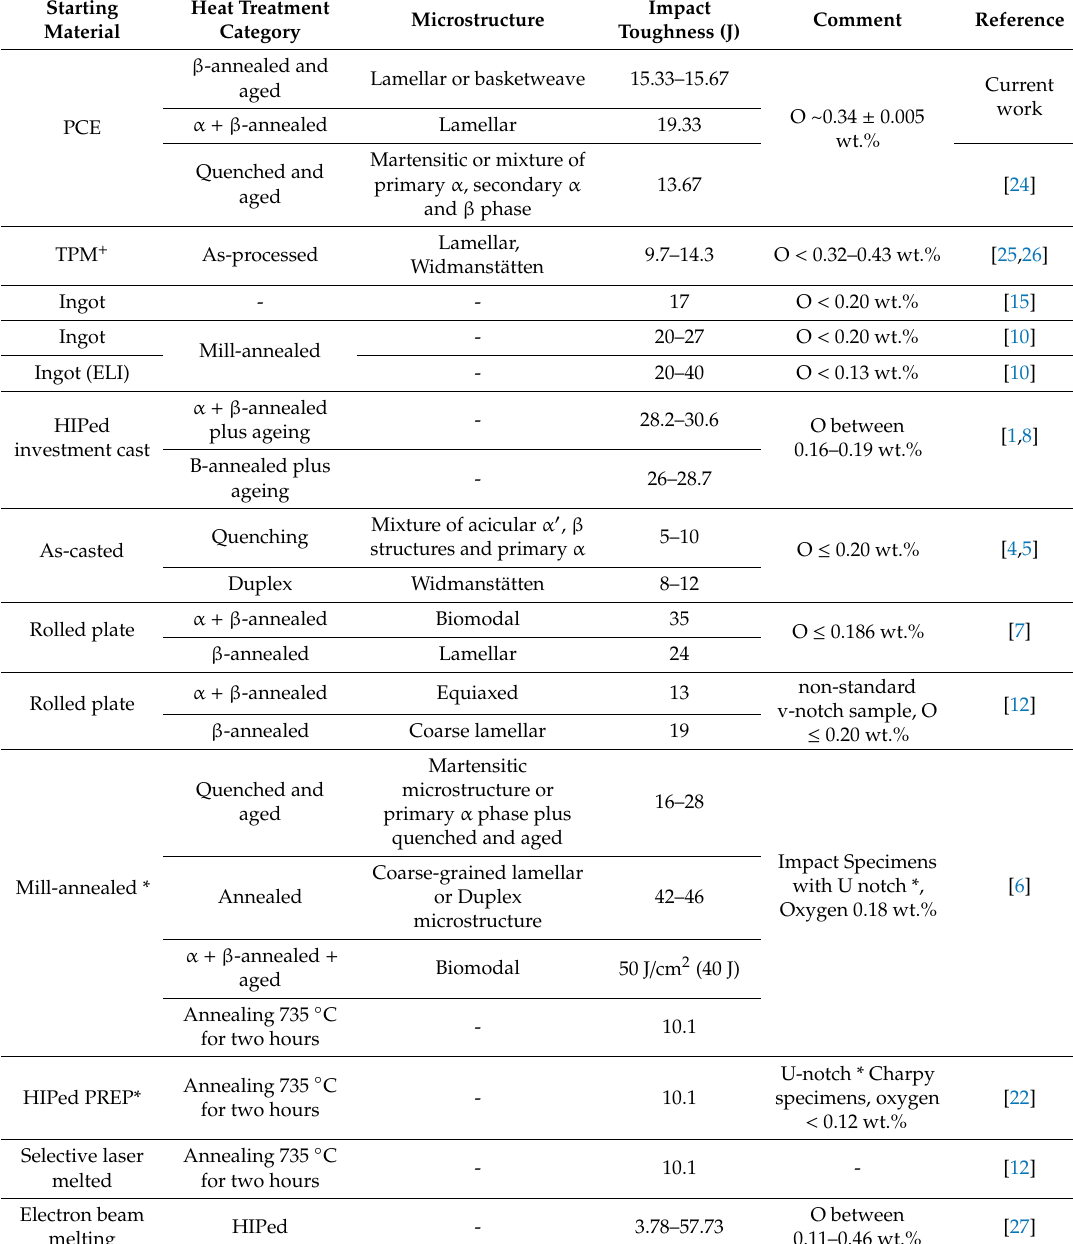
Table 4. A summary of previously published impact toughness data for heat-treated Ti-6Al-4V alloy produced via various processing routes (including ingot or powder